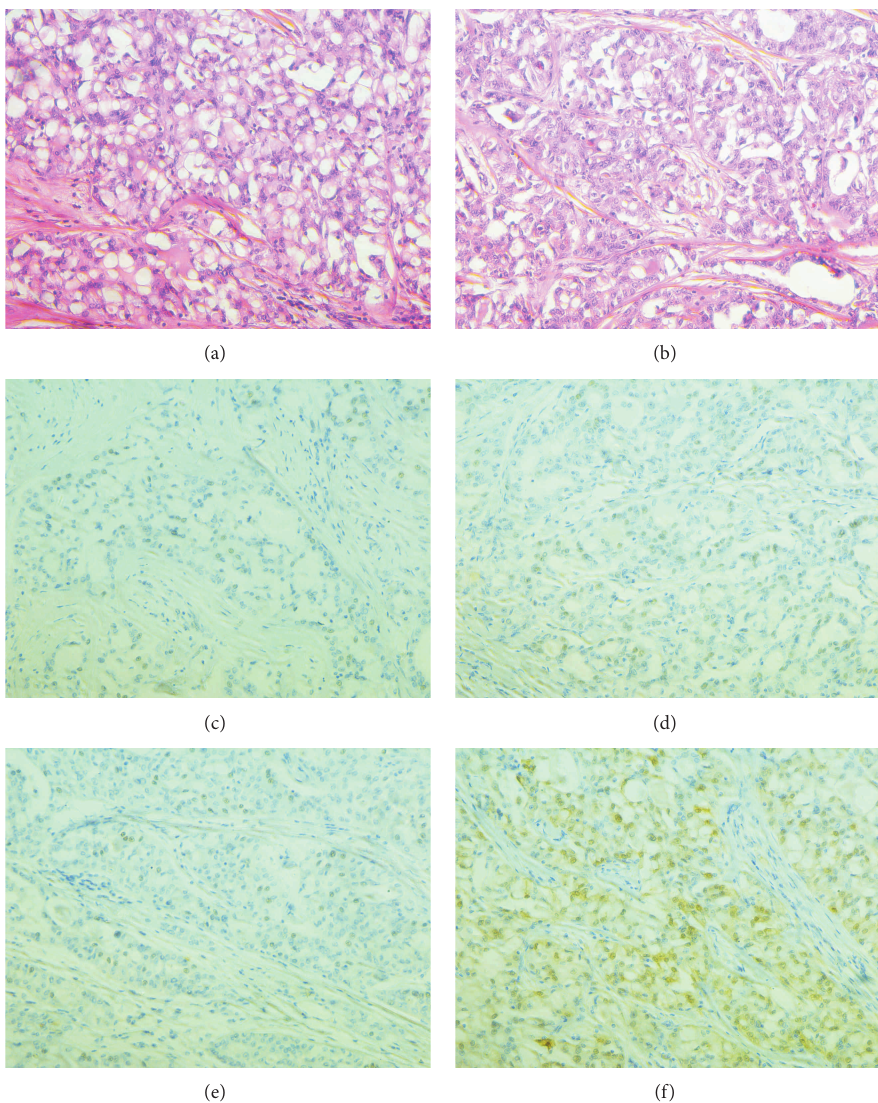
Figure 2: (a), (b) Hematoxylin and eosin showing sheets of glands. Immunohistochemistry for estrogen receptor (c), progesterone receptor (d), and HER 2neu (e) and S-100 positivity (f) each on